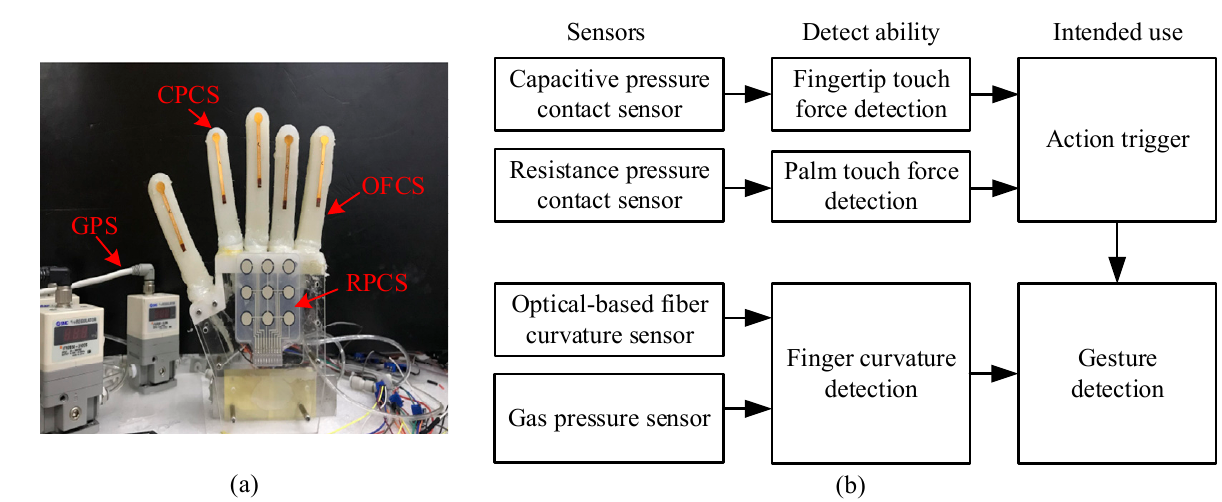
Figure 1. ( a ) The layout use of multimodal sensors. ( b ) The intended use of the sensors.